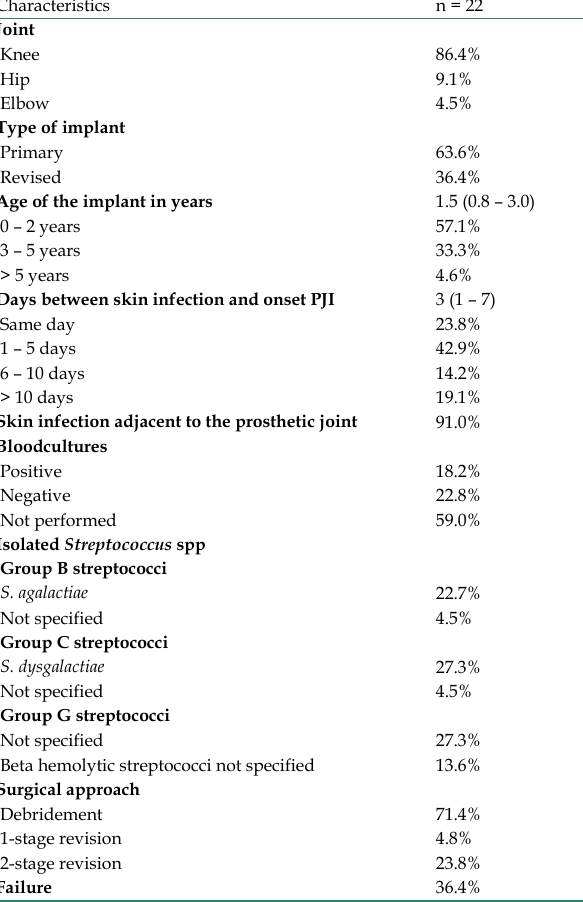
Table 1 . Clinical characteristics of patients who developed a streptococcal prosthetic joint infection (PJI) secondary to erysipelas or cellulitis. Data are presented as percentages or median